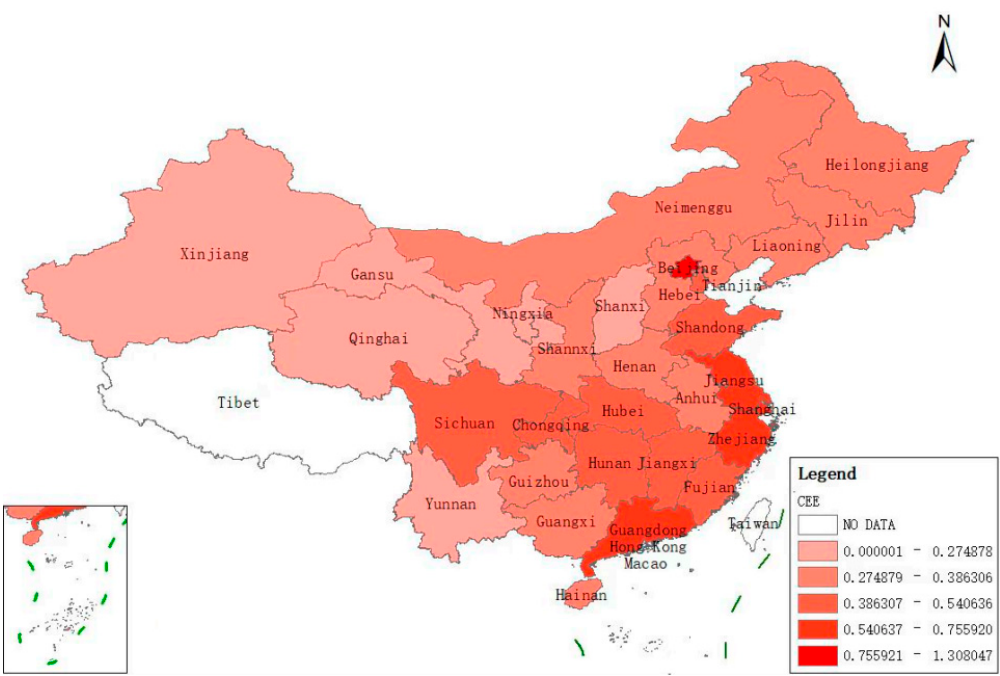
Figure 2. Average carbon emission efficiency (ACEE) in different Chinese provinces from 2016 to 2019 (Lin, G. [7]).